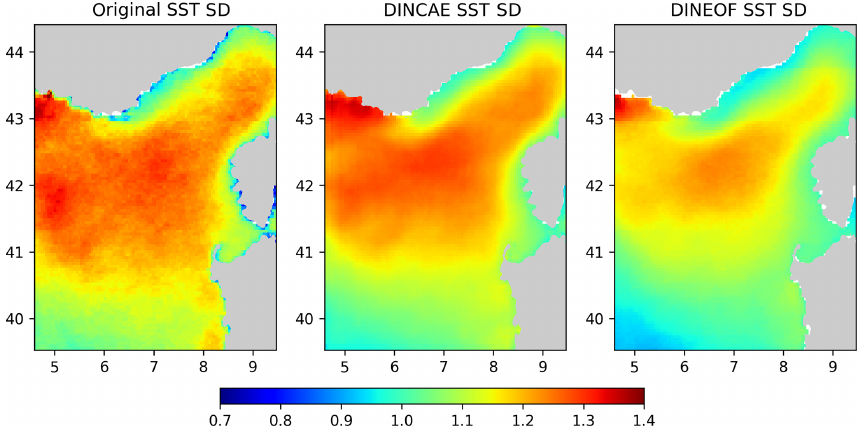
Figure 8. Standard deviation computed around the seasonal average in degrees